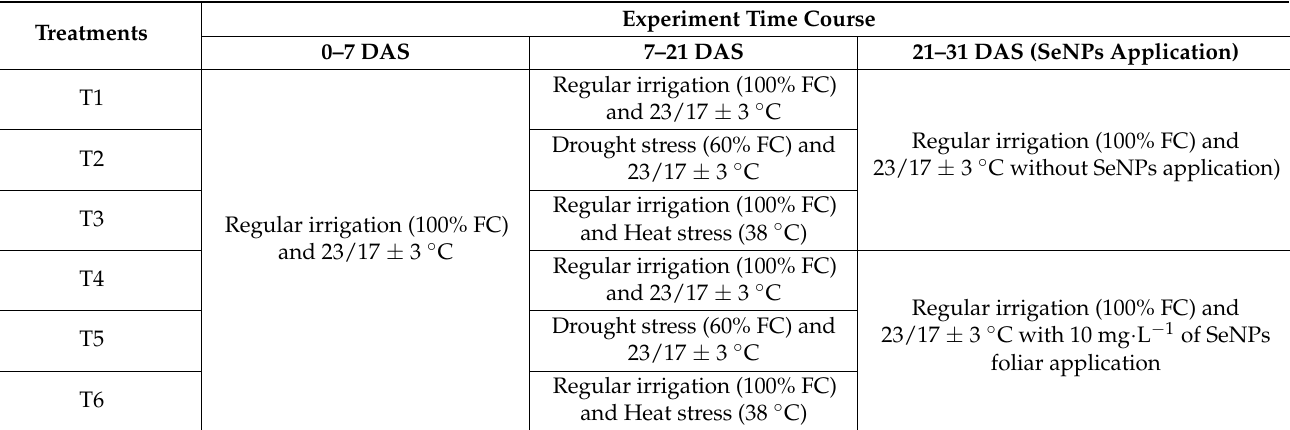
FC—Field Capacity, DAS—Days After Sown. Treatments: T1, control (regular irrigation, 100% Field Capac- ity (FC)) at (day/night) temperature of 23/17 ± 3 ◦ C; T2, drought stress (60% FC); T3, heat stress (38 ◦